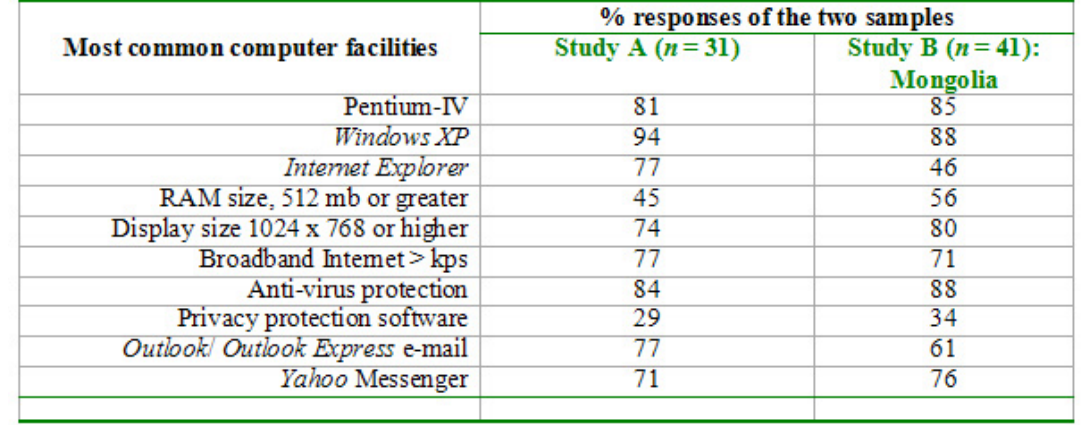
Table 1. Computer facilities of the two samples (Studies 1 and